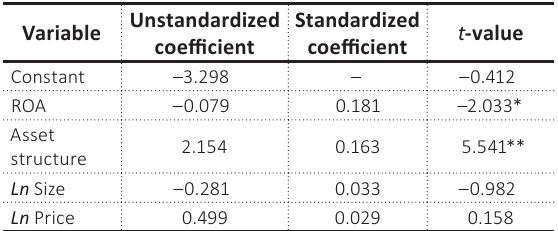
Table 5. Result of regression